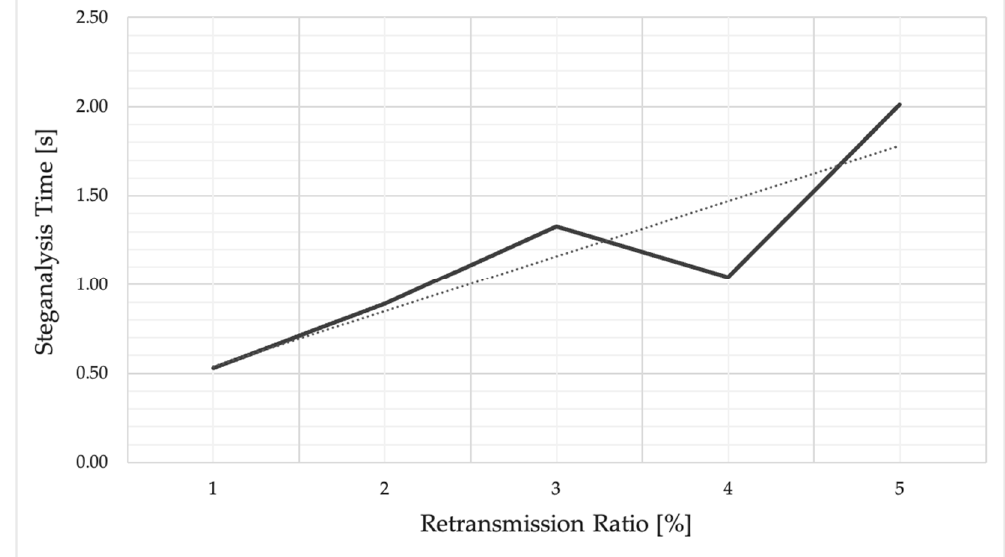
Figure 8. First-layer Steganalysis time.